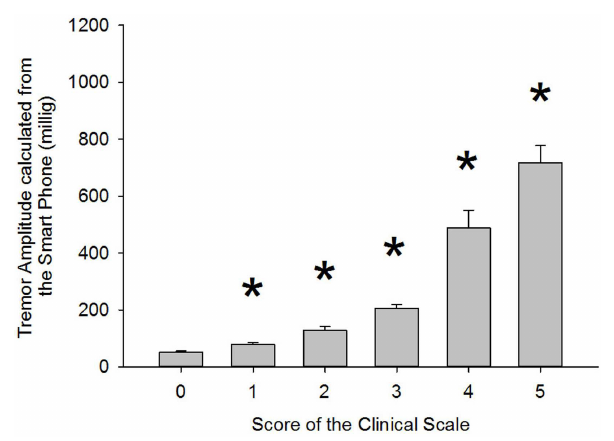
FIGURE 3 | Comparison of tremor amplitude recorded with the smart phone according to the clinical tremor score each trial was given. Asterisk (*) indicates a significant difference from the previous group. p Values were 0.004, 0.002, 0.001, 0.001, and 0.017 for the paired comparisons 0–1, 1–2, 2–3, 3–4, and 4–5, respectively.The associated power for those tests was 0.788, 0.869, 0.973, 1.000, and 0.638,